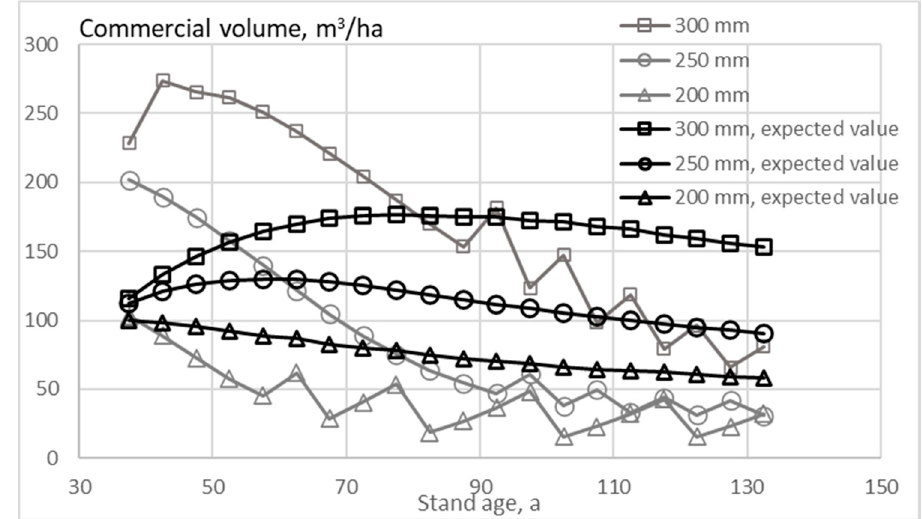
Figure 2. Commercial stem volume per hectare (thin markings) and expected value accumulated over stand age (thick markings) for three different cutting diameter limits (200 mm, 250 mm, and 300 mm).